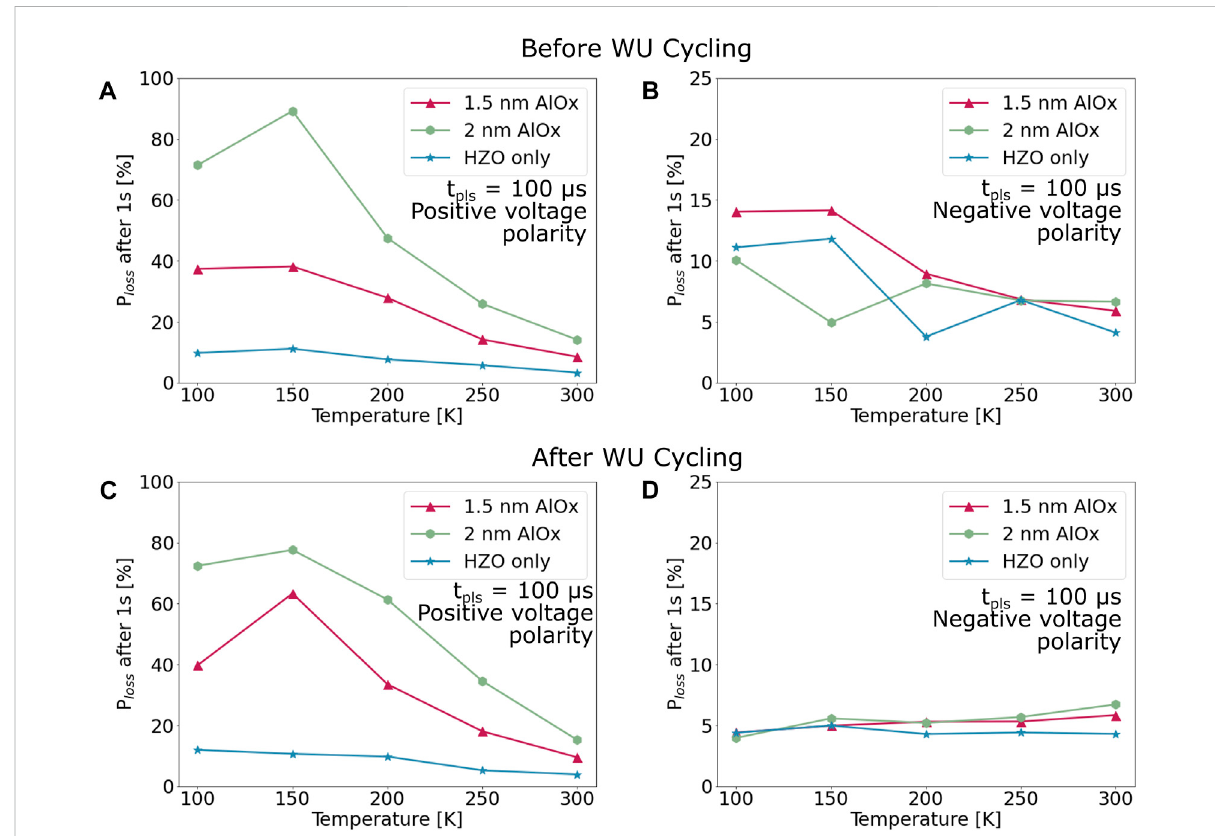
FIGURE 5 Polarization loss (P loss )as afunction of temperature, measured after 1 sdelaytime under no external bias (t del = 1 s), before wake-up cycling for (A) positive voltage polarity (P up state) and (B) negative voltage polarity (P down state); after wake-up cycling for (C) positive voltage polarity (P up state) and (D) negative voltage polarity (P down state). In all cases the polarization loss is normalized to the total switched charge measured on the initial pulse. Voltage amplitudes are 3.5 V (HZO only), 5.5 V (1.5 nm Al 2 O 3 ), 6 V (2 nm Al 2 O 3